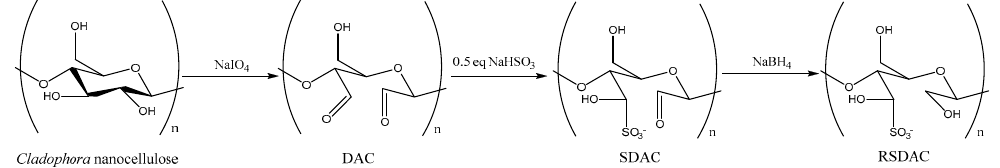
Figure 1. Chemical modifications of Cladophora nanocellulose to reduced sulfonated dialdehyde cellulose (RSDAC).